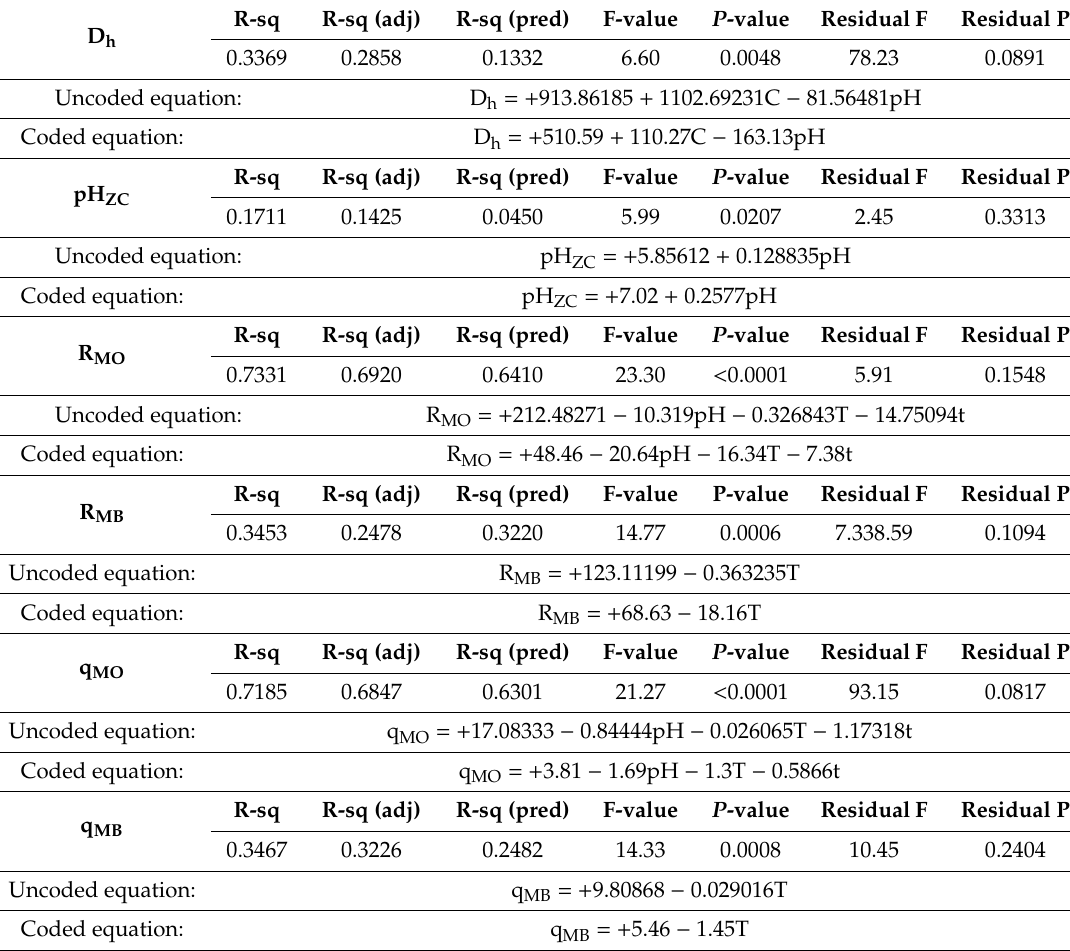
Table 3. The point of zero charge (pHzc), methyl orange (MO) and methylene blue (MB) removal e ffi ciencies (R MO and R MB , respectively), MO and MB adsorption capacities (q MO and q MB , respectively), and hydrodynamic diameter of ZnO particles (D h ) and their models